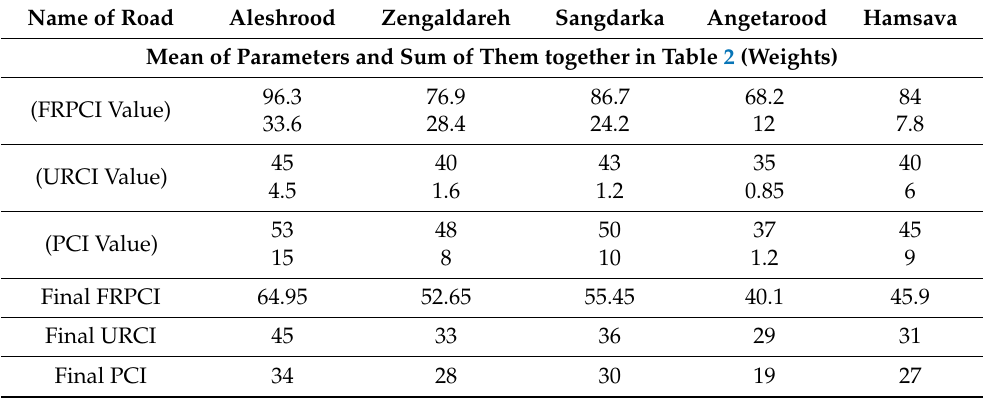
Table 5. Value of PCI for All of Forest Roads Pavement.